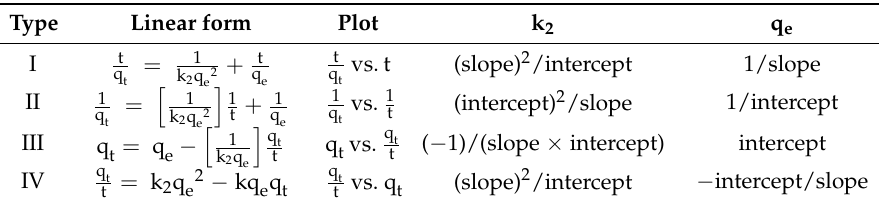
Table 4. Linear forms of PSO model (according to